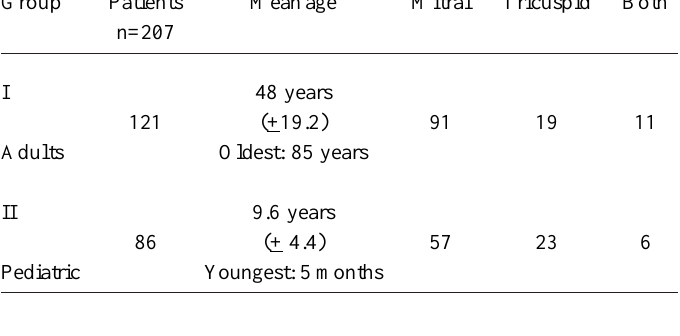
Table 1. Distribution of the atrioventricular valves requiring repair